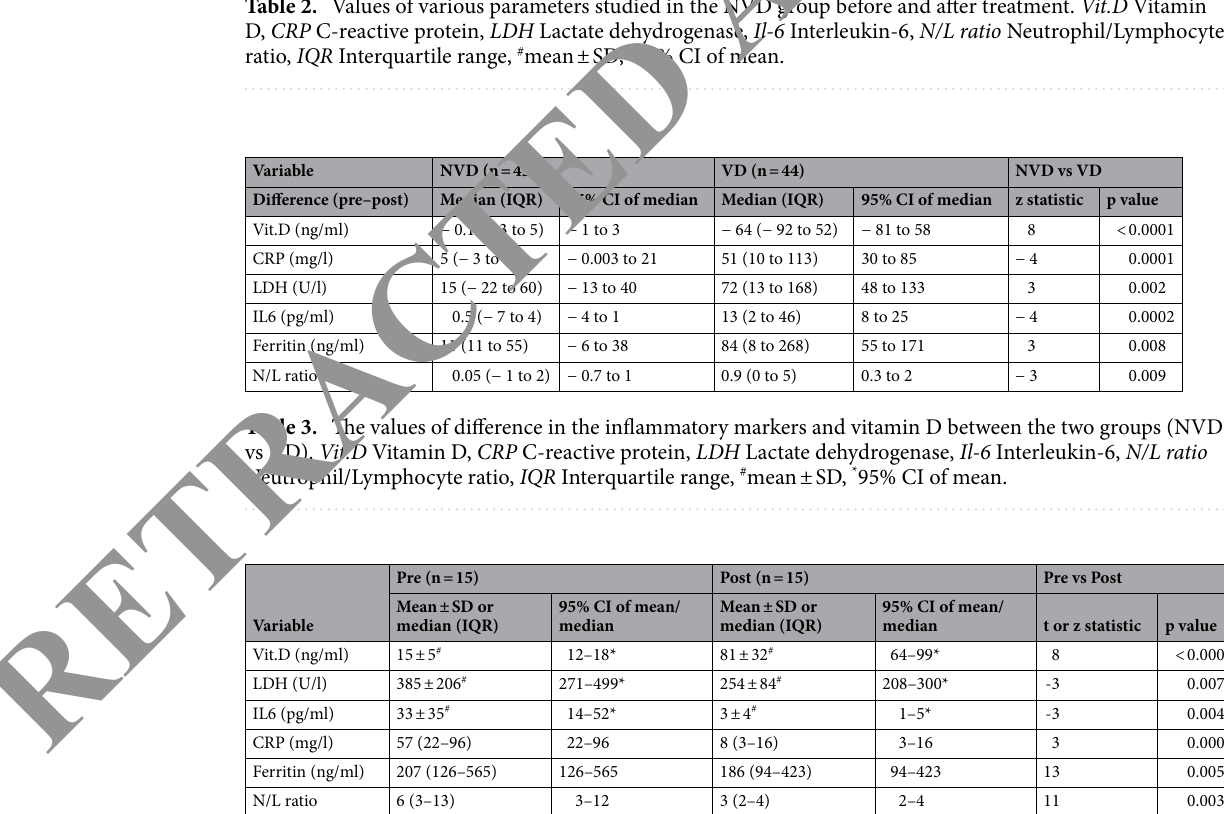
Table 4. Values of various parameters analysed in the eVD sub group before and after treatment. Vit.D Vitamin D, CRP C-reactive protein, LDH Lactate dehydrogenase, Il-6 Interleukin-6, N/L ratio